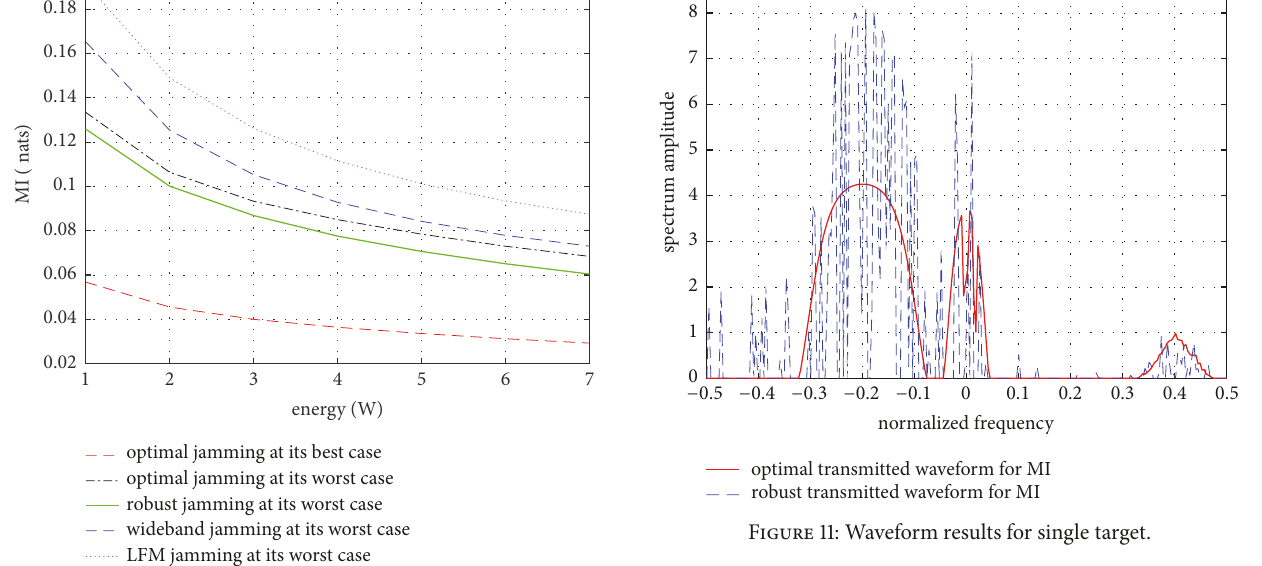
Figure 10: MI performance of the jamming results for multiple targets.